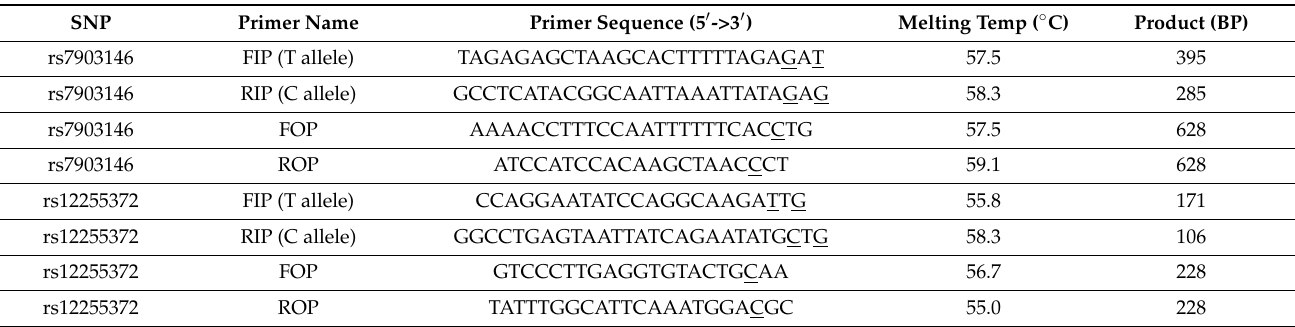
Table 6. Primers and concentration of